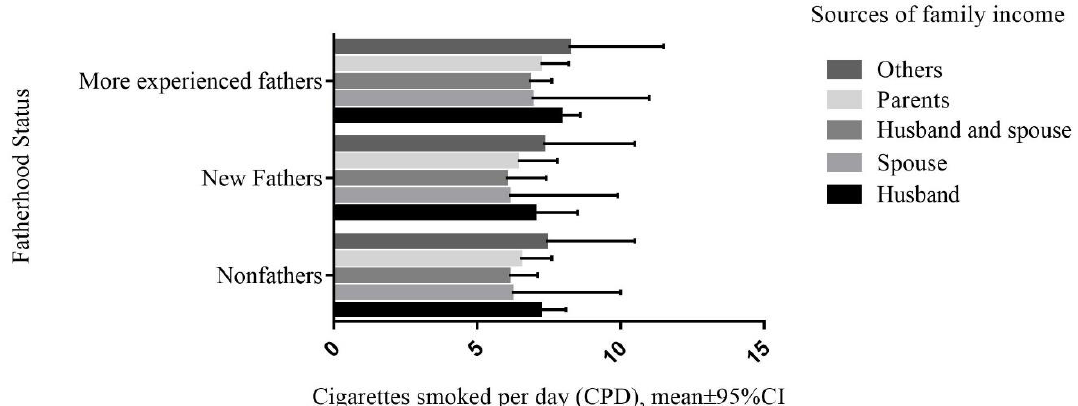
Figure 1. CPD and fatherhood status by sources of family income among nonfathers, new fathers and more experienced fathers.